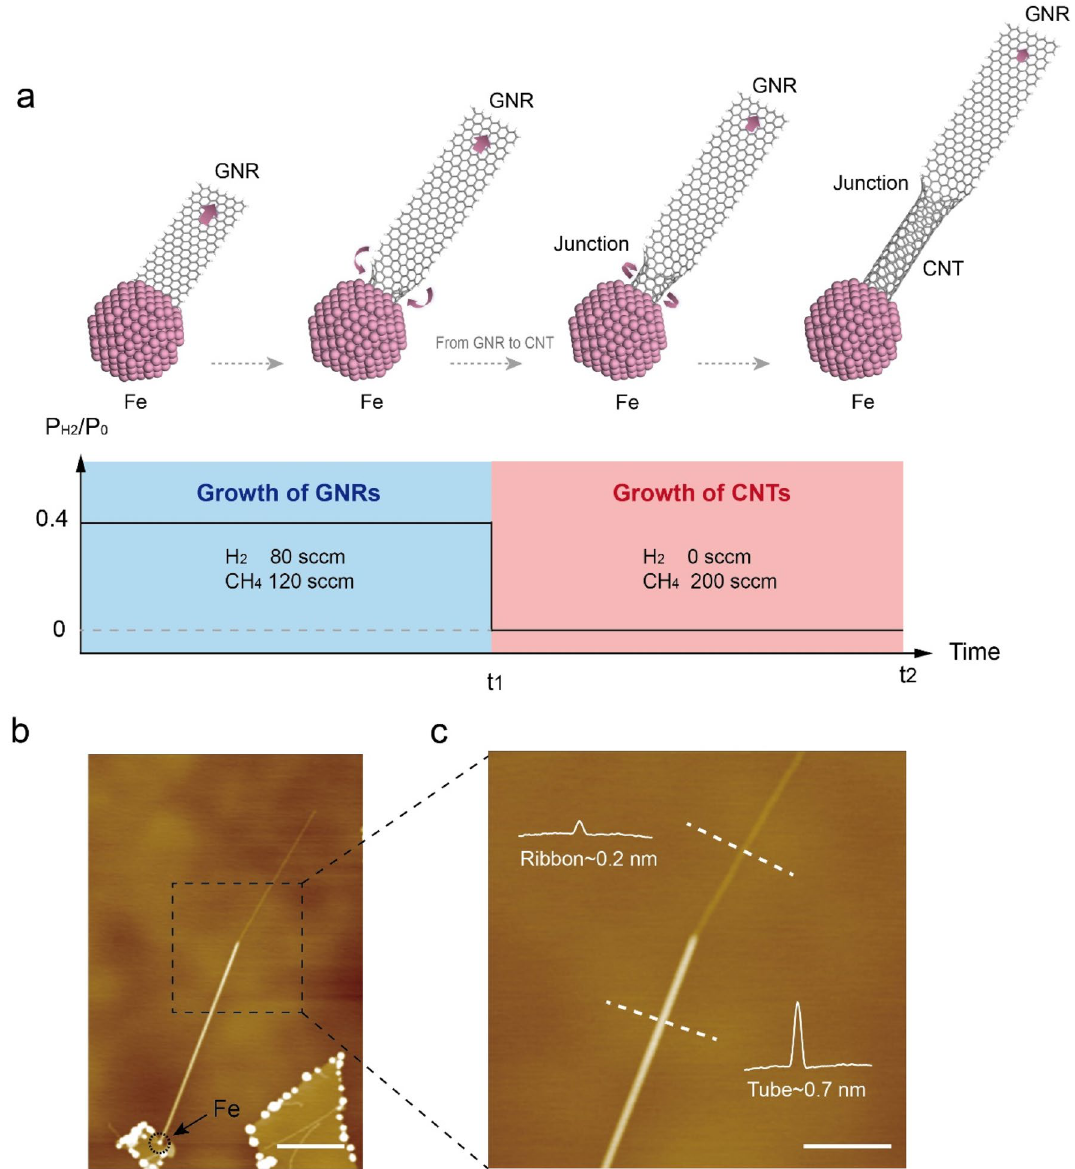
Figure 4. Growth of GNR/CNT junctions. ( a ) Schematic of growth of GNR/CNT junctions through abrupt change of H 2 pressure. The product switches from ribbon to tube, which yields a junction structure in the middle. ( b ) Topography of a typical GNR/CNT junction structure. ( c ) A zoom-in AFM image of the joint region in the dashed box in panel ( b ). Height profiles taken along the dashed lines show the tube height ~ 0.7 nm and ribbon height ~ 0.2 nm. Scale bars: 200 nm in ( b ); 100 nm in ( c